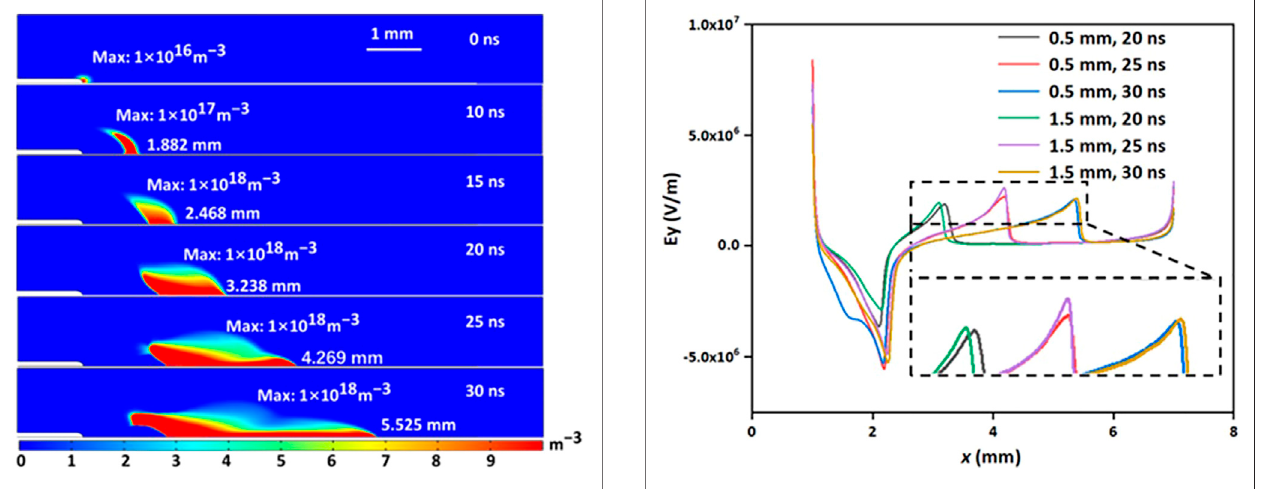
FIGURE 13 | E y component on the surface of thinner layer of graded permittivity.